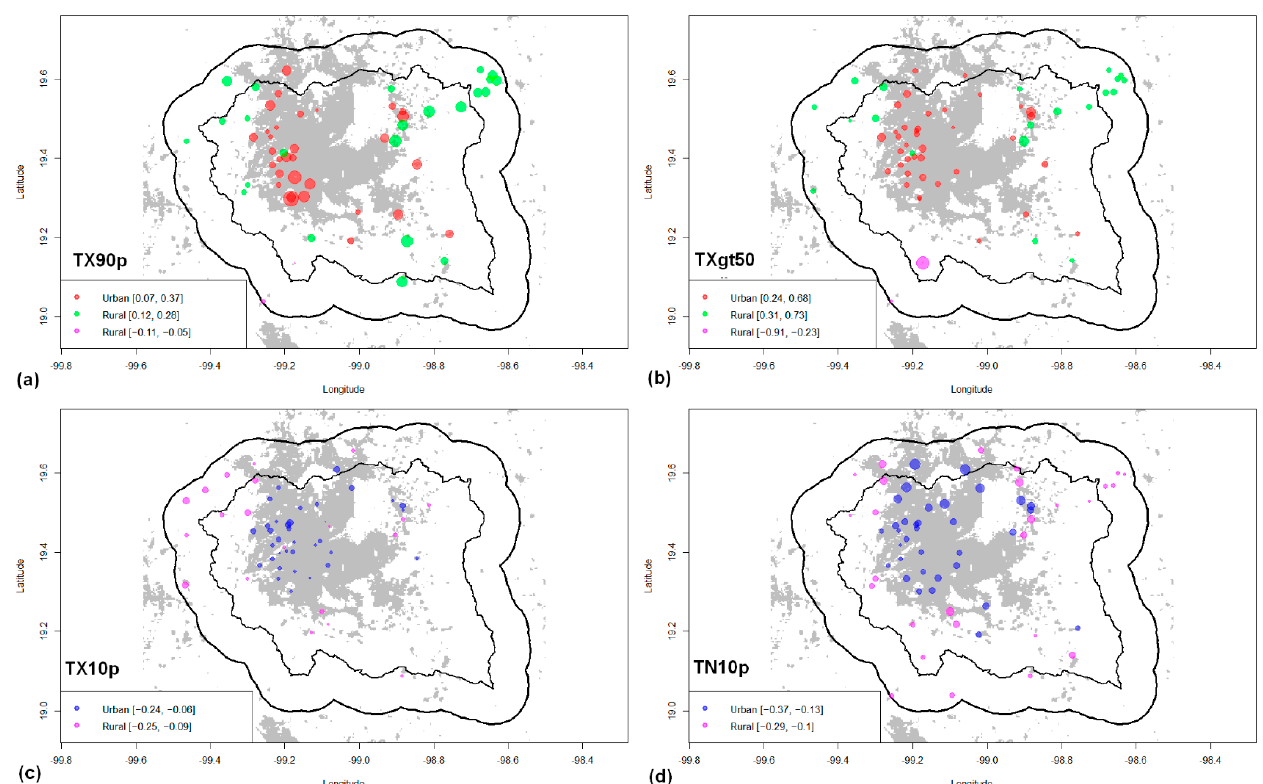
Figure 7. The same as in Figure 5 but for: ( a ) TX90p (°C/year), ( b ) TXgt50p (°C/year), ( c ) TX10p (°C/year), and ( d ) TN10p (°C/year).